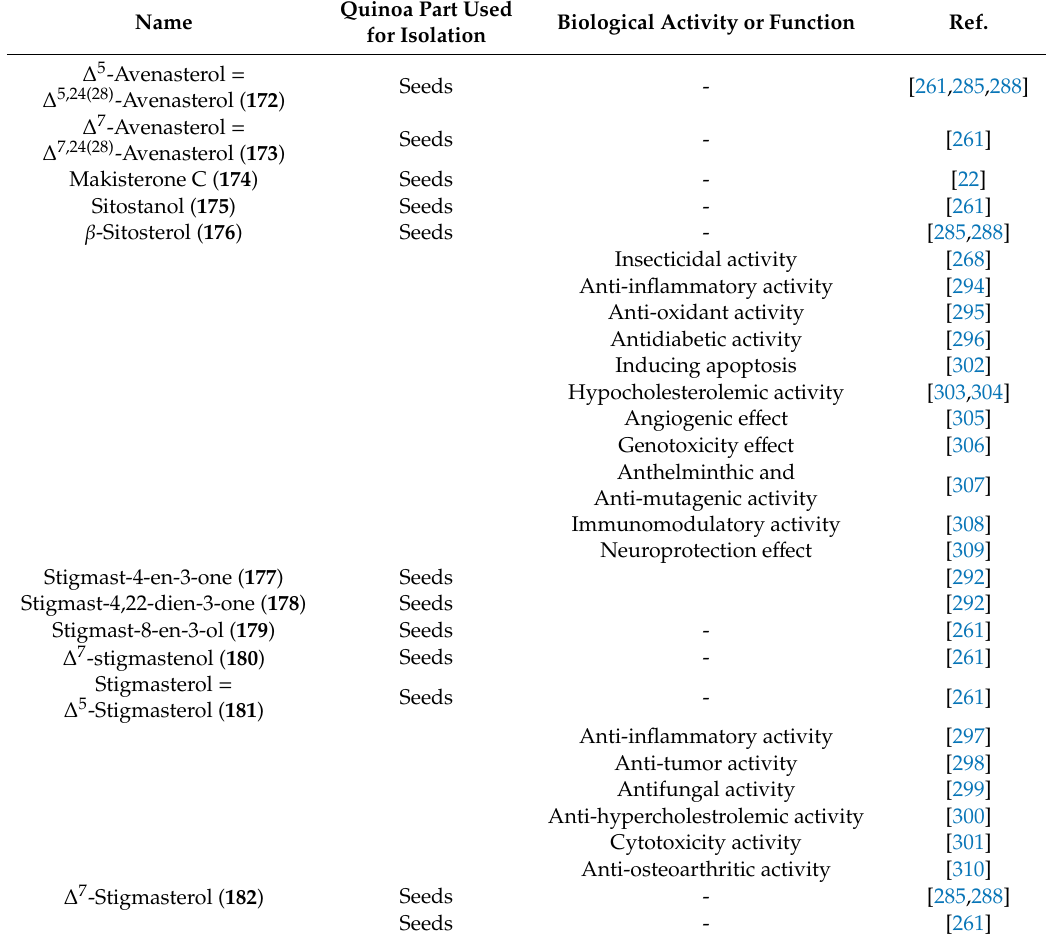
Table 21. C 29 -Steroids and their biological activities or